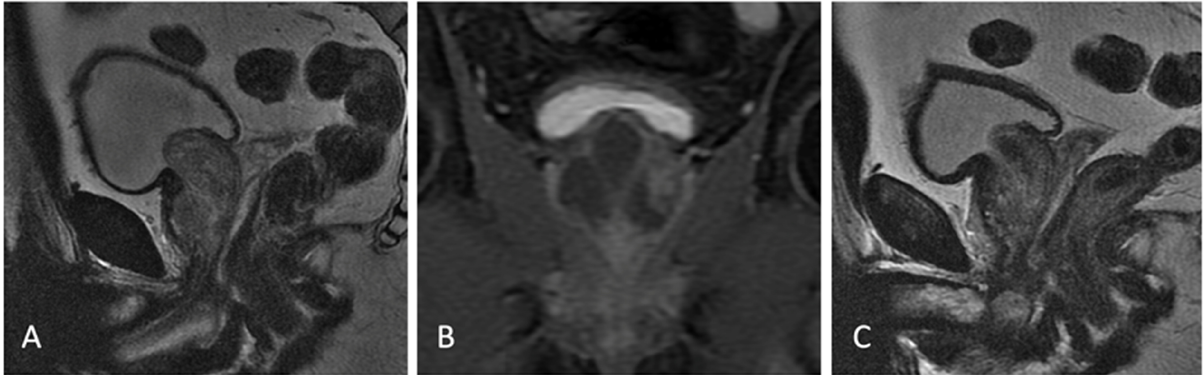
Fig. 6. 59-year-old patient with pronounced LUTS (IPSS 27), severely impaired quality of life and without impairment of erectile function (IIEF 24). The patient explicitly desired ejaculation-preserving therapy. (A) Pretherapeutic diagnostic MRI (sag T2w) with the pronounced IPP. (B) Coronal angulated ceMRI 48 hours post PAE clearly shows complete devascularisation of the TML. (C) Follow-up MRI 2 months post PAE shows a marked reduction in IPP with persistent signs of